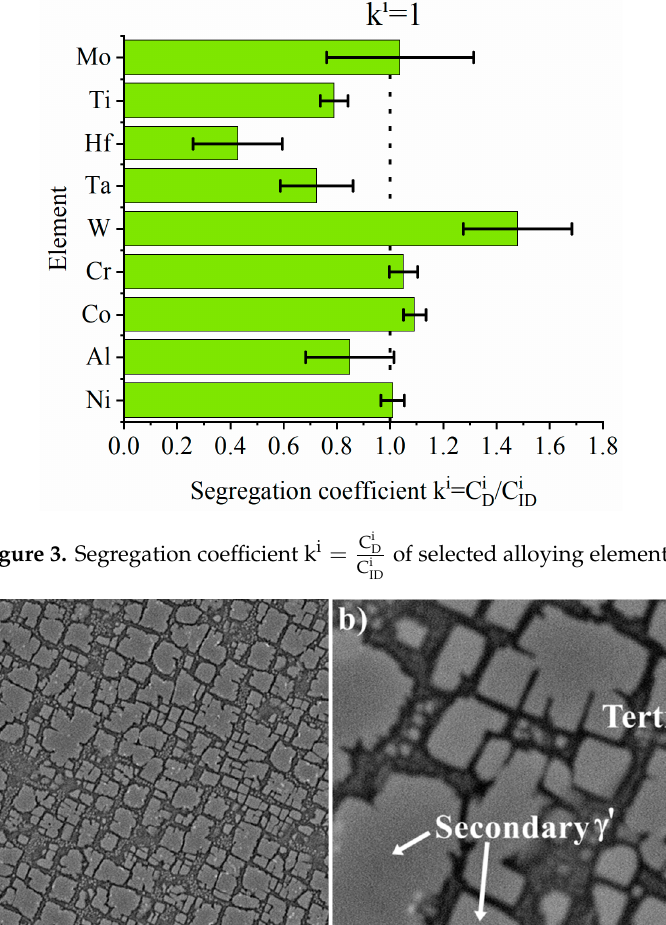
Figure 4. Microstructure of precipitates in a dendrite arm: ( a ) secondary γ (cid:48) ; ( b ) secondary and fine tertiary γ (cid:48) .